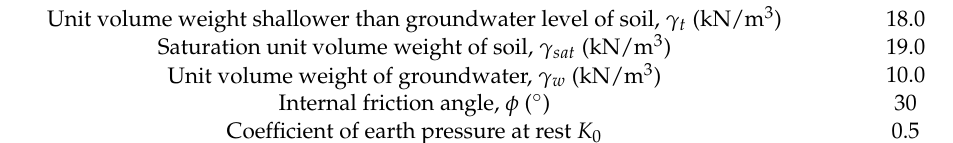
Table 3. Assumed conditions for ground around manhole (sandy soil).